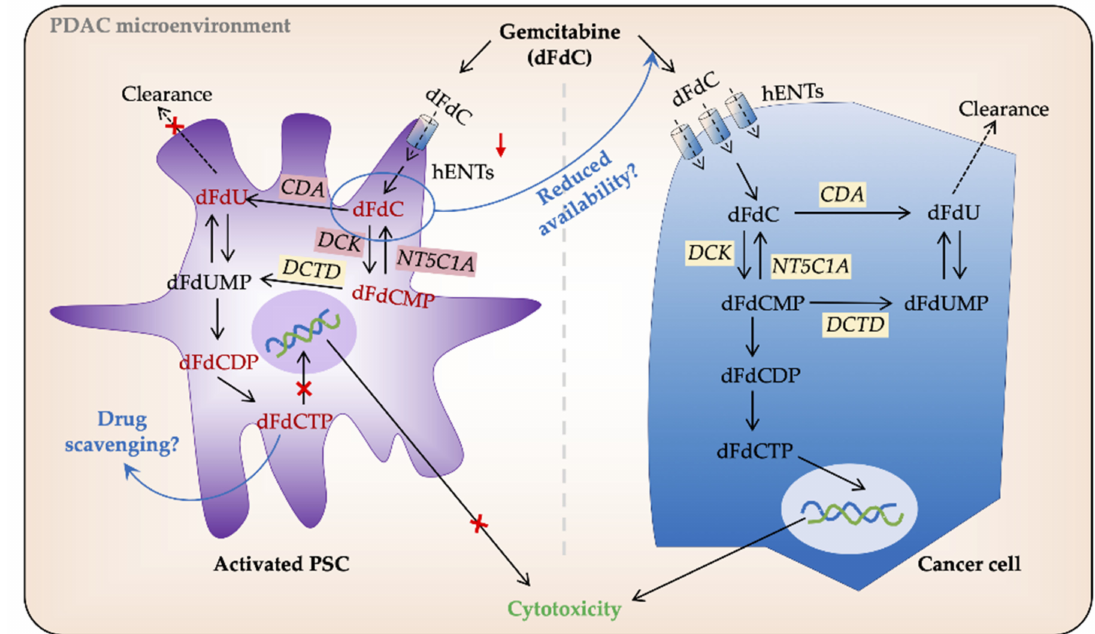
Figure 2. Gemcitabine processing in PSCs and cancer cells. In pancreatic cancer (PC) cells gemcitabine (2 (cid:48) ,2 (cid:48) -difluoro-2 (cid:48) - deoxycytidine; dFdC) is transported intracellularly by human equilibrative nucleoside transporters (hENTs). Once inside the cell, its major proportion is inactivated by cytidine deaminase (CDA) and secreted extracellularly. The remaining gemcitabine is activated, mainly by deoxycytidine kinase (DCK), to its subsequent mono-, di-, and tri-phosphate forms dFdCMP, dFdCDP, and dFdCTP, respectively. dFdCTP competes with the substrate for DNA synthesis and induces cell death by apoptosis. Low/no expression of hENTs and other gemcitabine metabolizing enzymes reduce gemcitabine uptake and processing in PSCs. However, a large volume of PDAC tumors is made up of PSCs, and thus, any amount of gemcitabine uptake by PSCs may result in its reduced availability for PC cells. Similarly, intracellular entrapment of dFdCTP by PSCs is speculated to result in drug scavenging. DCTD, deoxycytidylate deaminase; dFdU, 2 (cid:48) ,2 (cid:48) -difluoro-2 (cid:48) -deoxyuridine; dFdUMP, 2 (cid:48) ,2 (cid:48) -difluoro-2 ´ -deoxyuridine monophosphate; NT5C1A, 5 (cid:48) -nucleotidase cytosolic 1A; PSC, pancreatic stellate